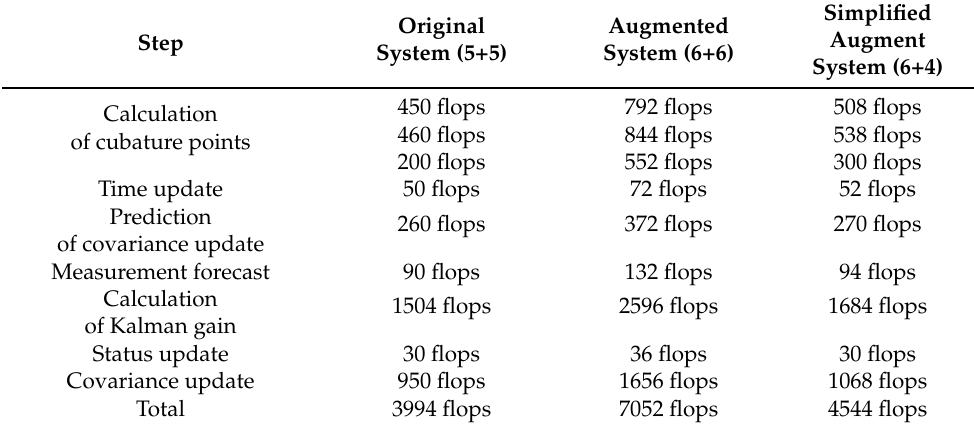
Table 1. Computational complexity analysis of three